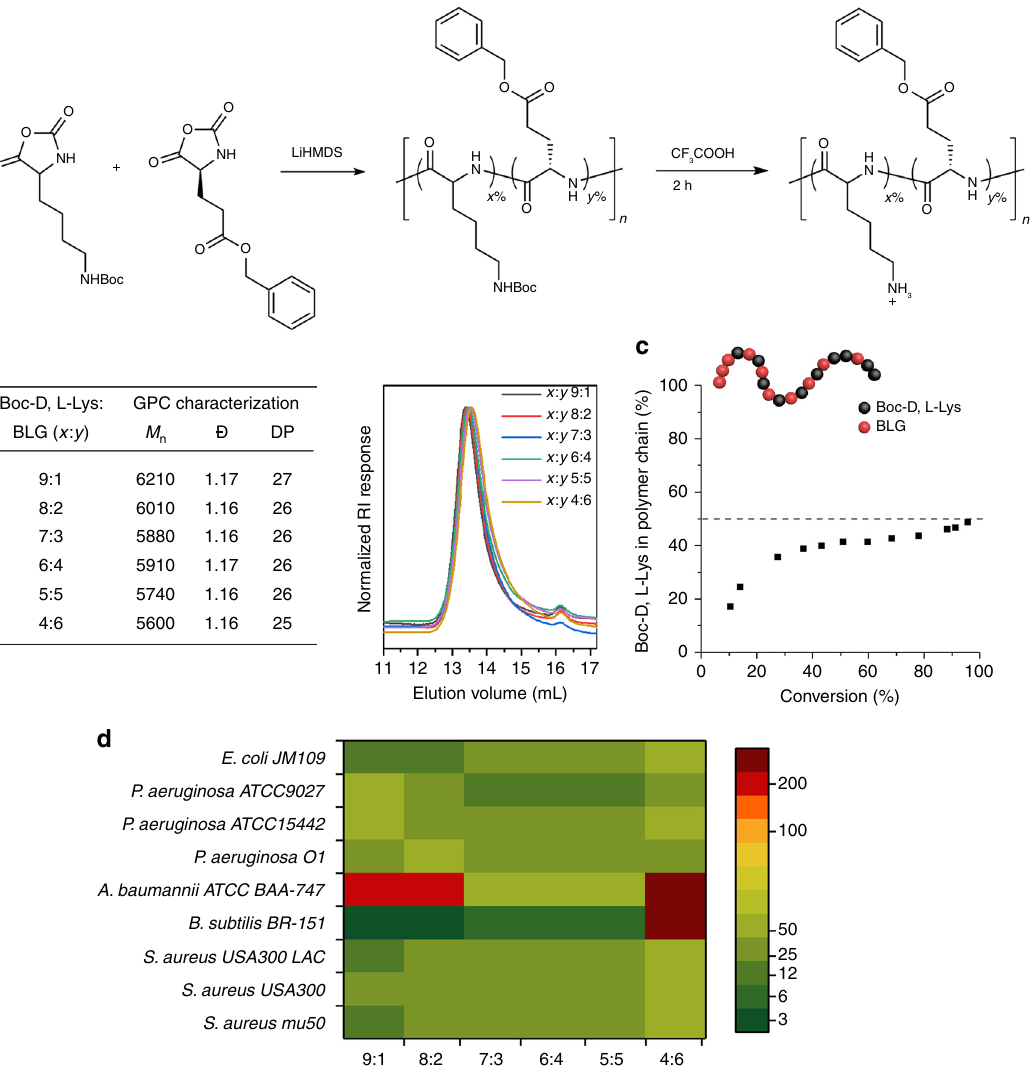
Fig. 5 Fast library synthesis of polypeptides for antibacterial activity studies. a LiHMDS-initiated polymerization of a mixture of BLG NCA and Boc-D,L-Lys NCA in variable NCA ratios, b characterization and GPC traces of resulting polymers at the NHBoc protected stage. Mn is the obtained number average molecular weight, Đ is the dispersity index, DP is the obtained degree of polymerization; c plot of subunit composition within polymer chains against total NCA conversion; d plot of deprotected polypeptides ’ antimicrobial activities (MIC) against ratios of subunits ( x : y Boc-D,L-Lys:BLG) within these co- polymers, with BLG, the hydrophobic subunit, varied from 10% to 60%